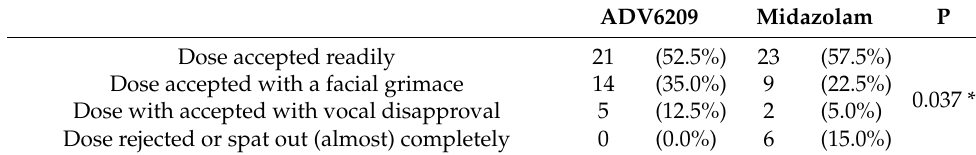
Table 4. Acceptance of the premedication